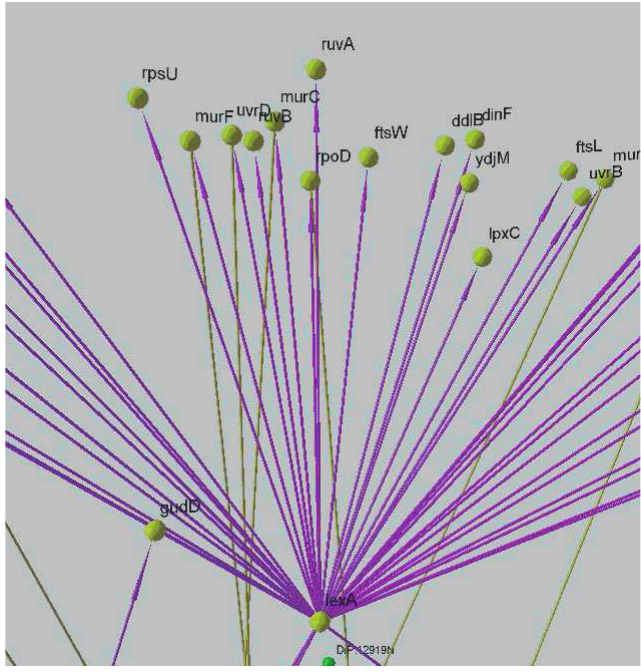
Figure 6: Enlargement of the visualisation in Figure 4, see text for an